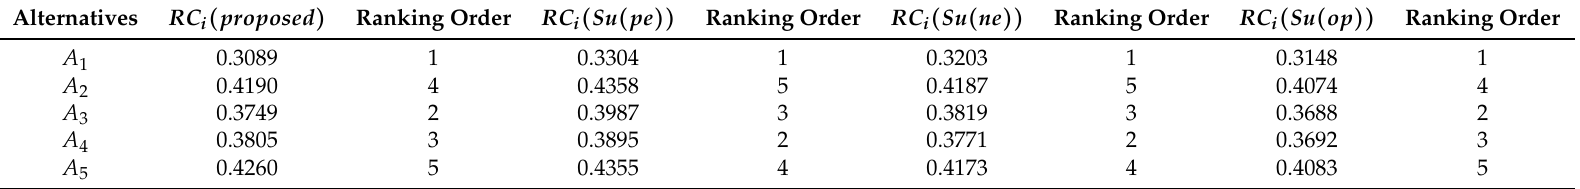
Table 8. Ranking order of five nations derived from different distance